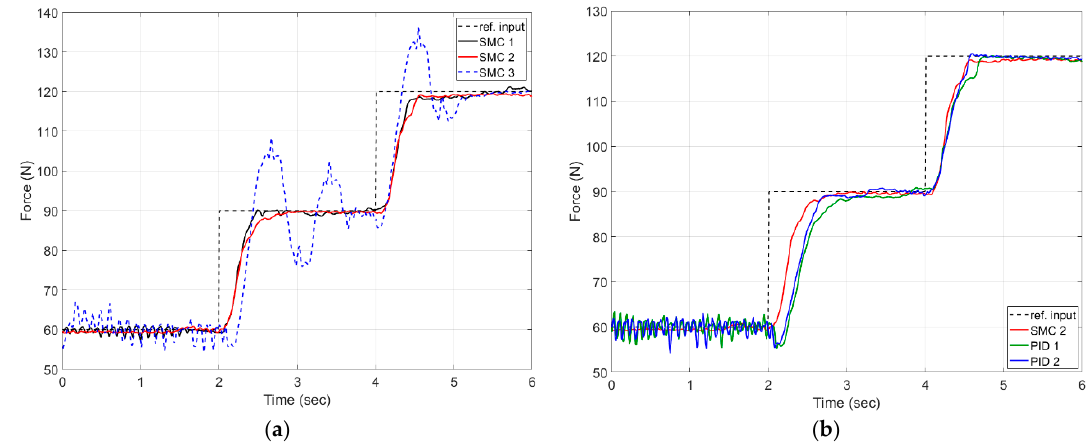
Figure 13. Comparisons of the experimental results: ( a ) is the force control performance of SMC, and ( b ) is a comparison of SMC and PID control.